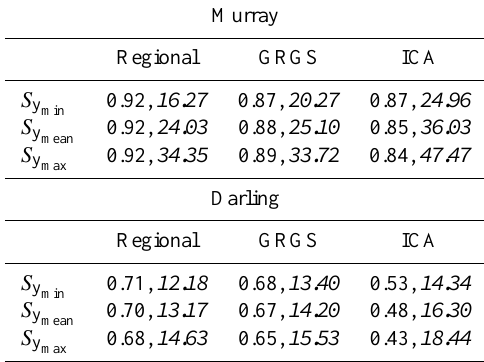
Table 4. Correlation (first value) and RMS of the difference (sec- ond value in italic) between time series over Murray and Darling computed from different GRACE solutions and the modelled/in situ estimates (SM+SW+GWS) using the maximum, mean and mini- mum values of the specific yield. RMS units are mm of